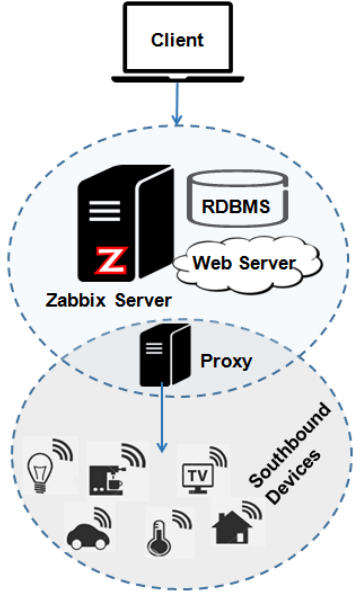
Figure 15. Illustration of the Zabbix